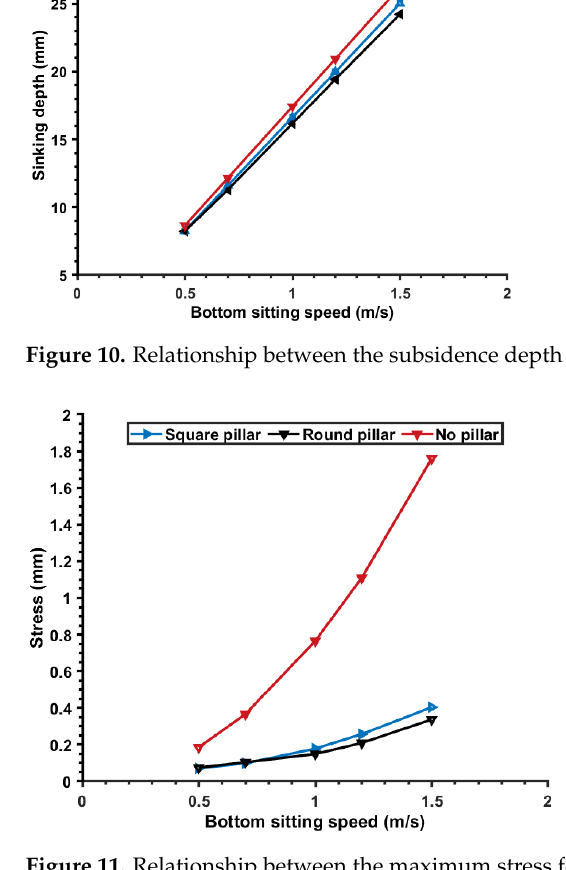
Table 3. Statistical table of maximum stress suffered by sediment unit: MPa. Figure 11. Relationship between the maximum stress force and the bottom subsidence speed.